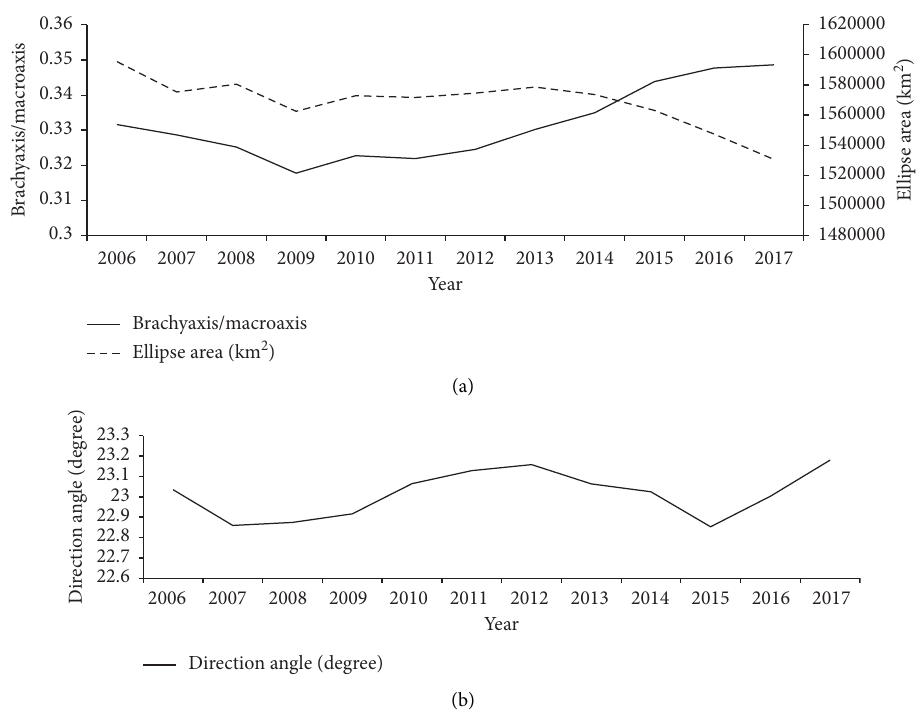
Figure 5: Change trends of marine economic efficiency between 2006 and 2017. (a) Changes in range and shape. (b) Changes in direction